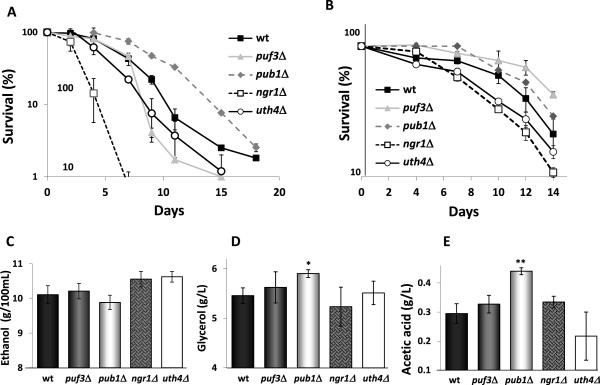
Deletion of mRNA binding proteins alters lifespan under different growth conditions. Genes were deleted from haploid wine yeast C9. A) The CLS experiments in laboratory medium SC. Viability after three days in SC is taken as 100% survival. Aliquots of each culture were taken, diluted, plated and counted over time. B) The CLS plots during the grape juice fermentation of the same deletion strains. Other conditions as in Figure 1C. Production of ethanol (C), acetic acid (D) and glycerol (E) in the vinifications described in Panel (B). Experiments were done in triplicate and the mean and standard deviation are provided. *p<0.05, **p<0.01, unpaired t-test, two-tailed.